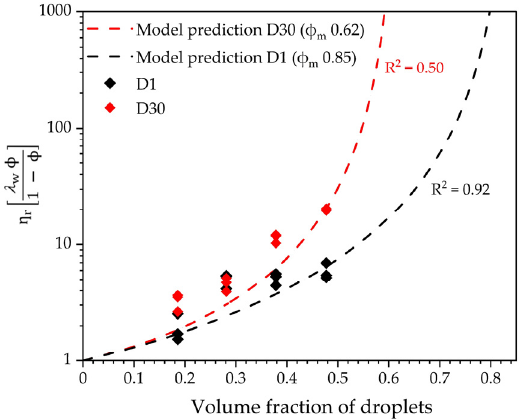
Figure 3. Modelling the relative viscosity of LMP emulsions containing 20–50 wt.% water and 7 wt.% HSO using the modified Pal model (Equation 3) for day 1 ( ϕ m = 0.85) and day 30 ( ϕ m = 0.62).